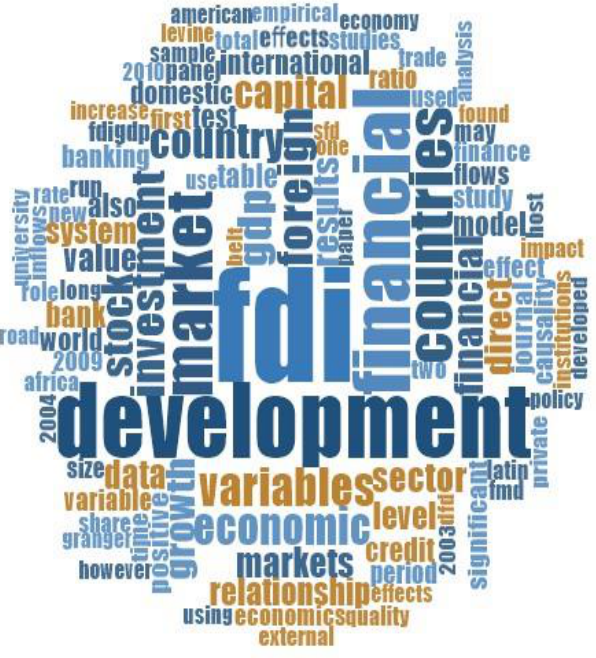
Figure 1: Word cloud for most common words in FD-FDI